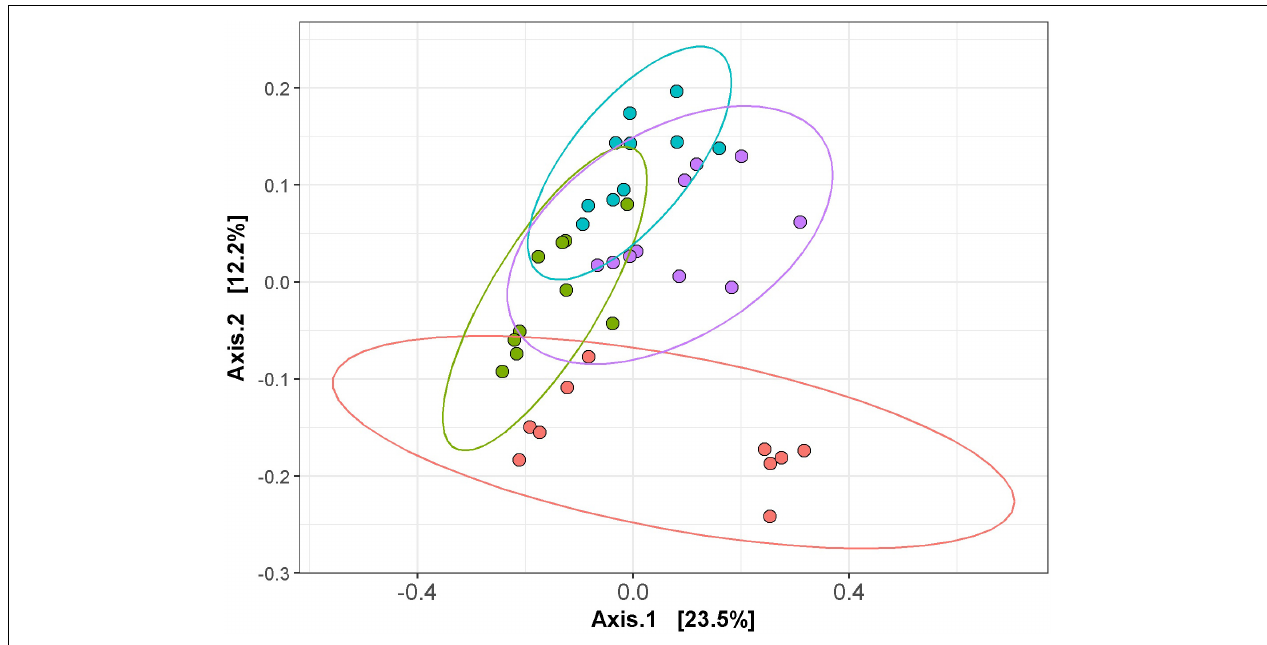
FIGURE 3 | Principal coordinates analysis (PCoA) of the mouse cecal sequencing data at day 7, based on unweighted UniFrac distances, generated with phyloseq in R (version 3.2.2). The control and test groups are represented by color; control (red), L. gasseri APC 678 (green), L. rhamnosus DPC 6111 (blue) and L. gasseri ATCC 33323 (purple) and ggplot2 in R was used to compute the 95% confidence interval for the ellipses.